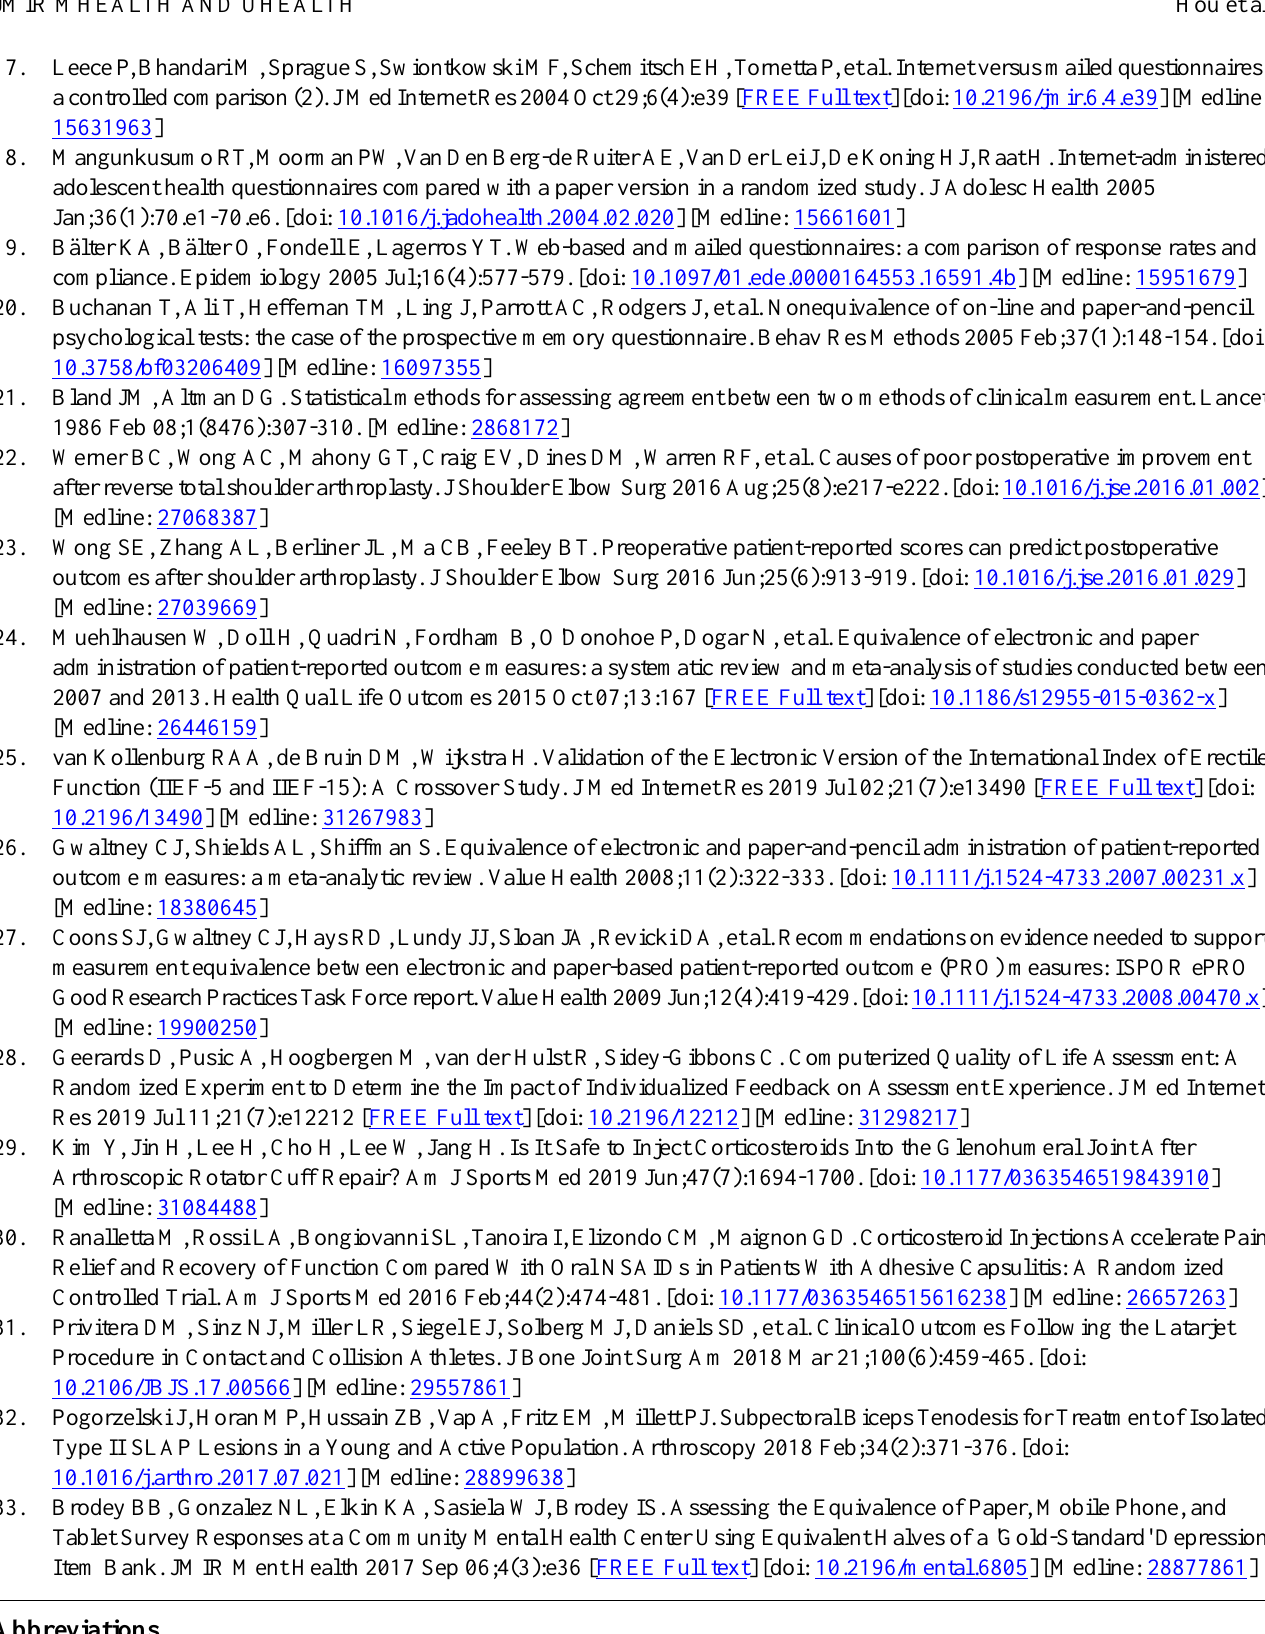
ASES: American Shoulder and Elbow Surgeons Standardized Shoulder Assessment Form ePROM: electronic patient-reported outcome measure ICC: intraclass correlation coefficient PROM: patient-reported outcome